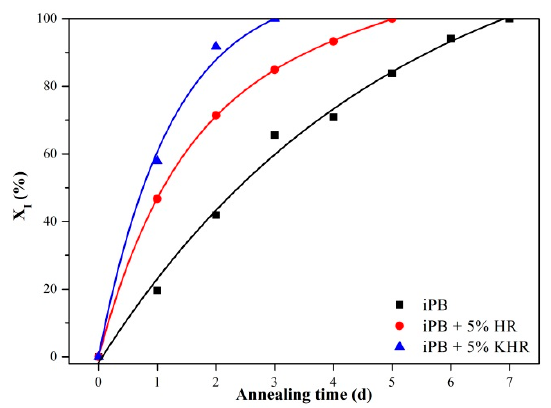
Figure 5. The crystal form transformation kinetics of the